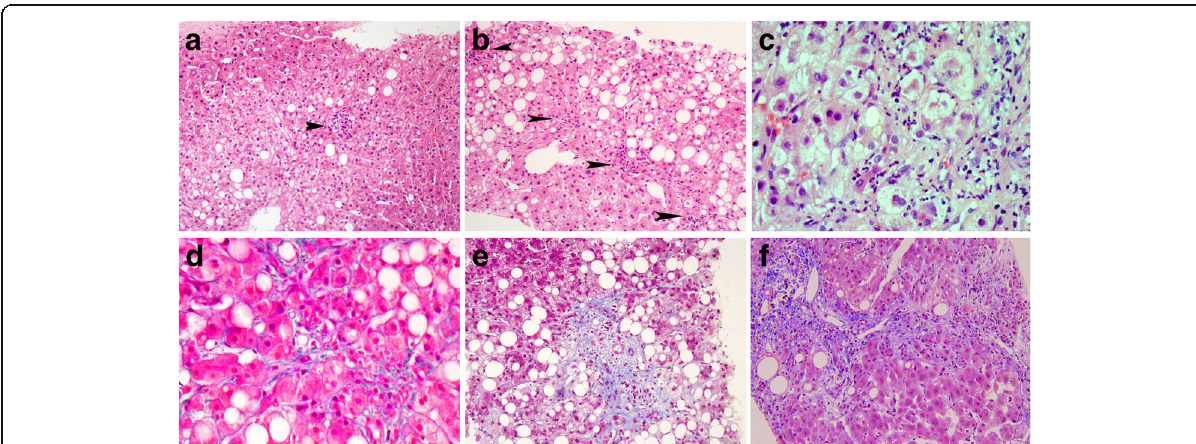
Fig. 1 Representative histomorphologic features of hepatic steatosis. ( a ) Lobular inflammation, with a single focus of inflammatory cells (arrow) (H&E). ( b ) Lobular inflammation, with four foci of inflammatory cells (arrows) (H&E). ( c ) Ballooning degeneration, with many enlarged hepatocytes including at least one twice the size of a normal cell (H&E). ( d ) Perisinusoidal fibrosis (Masson ’ s trichrome). ( e ) Periportal fibrosis (Masson ’ s trichrome). ( f ) Septal fibrosis (Masson ’ s trichrome)